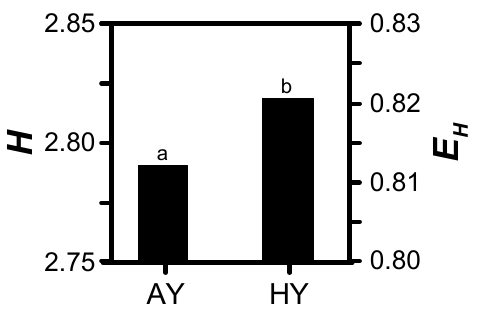
Figure 3. Shannon’s diversity ( H ) and evenness ( E H ), averaged across regions, measured in the average- (AY) and high-yield (HY) areas of the “Grow for the Green” yield contest across Arkansas in 2014 and 2015. Bars with different letters are significantly different (i.e., p ≤ 0.05).